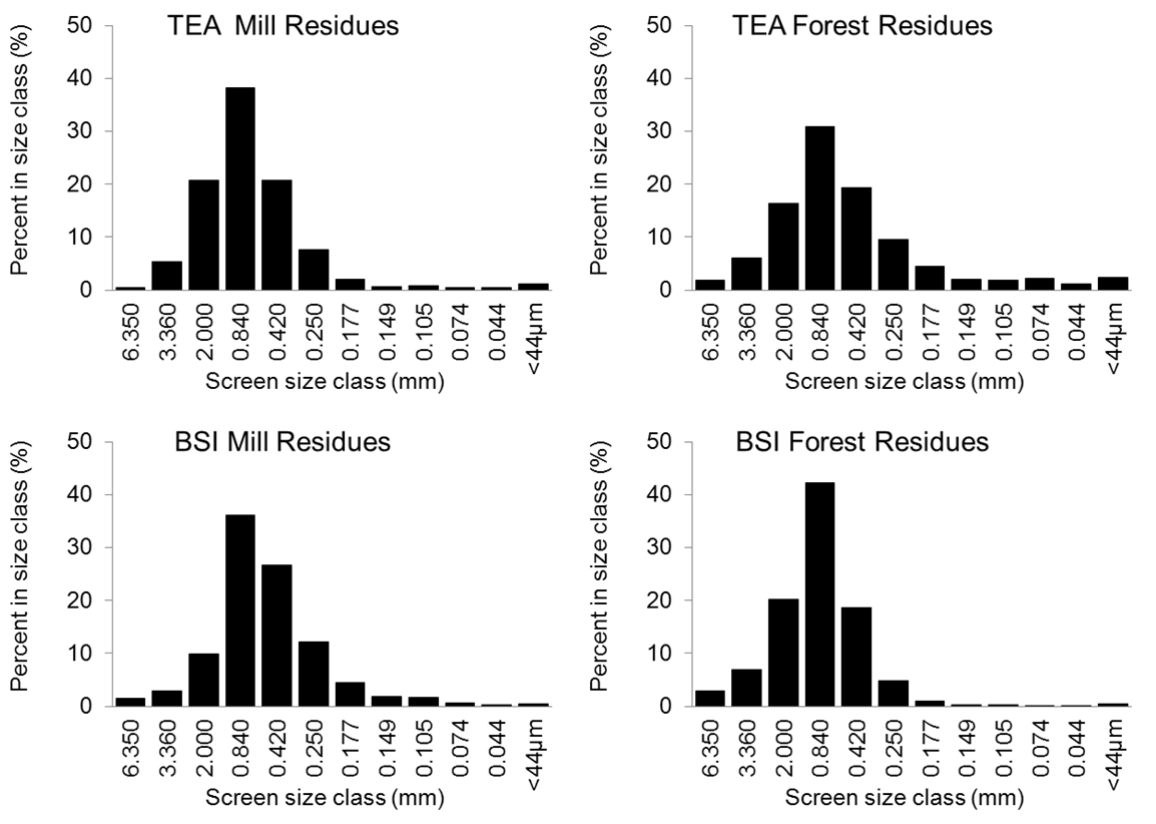
Figure 4. Biochar particle size